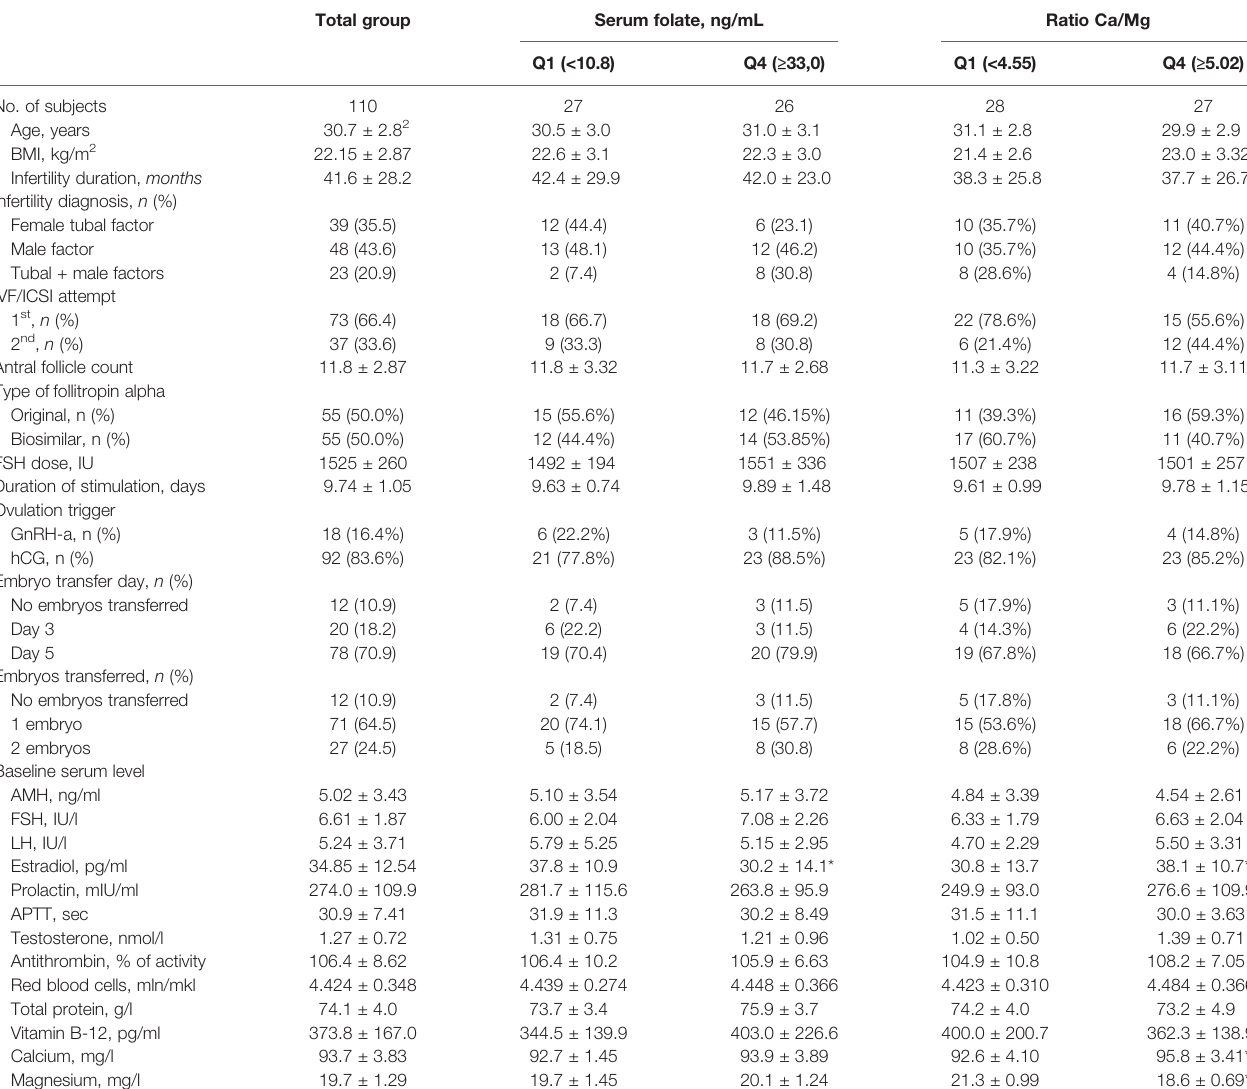
TABLE 1 | Baseline characteristics of 110 women by the quartile range of the serum folate level and Ca/Mg ratio 1